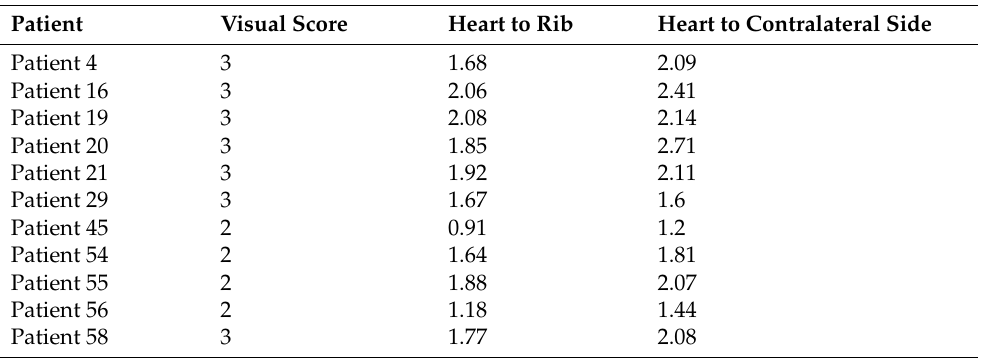
Table 2. Semiquantitative Method, results for ATTR positive patients on static centered-on-the-thorax images.